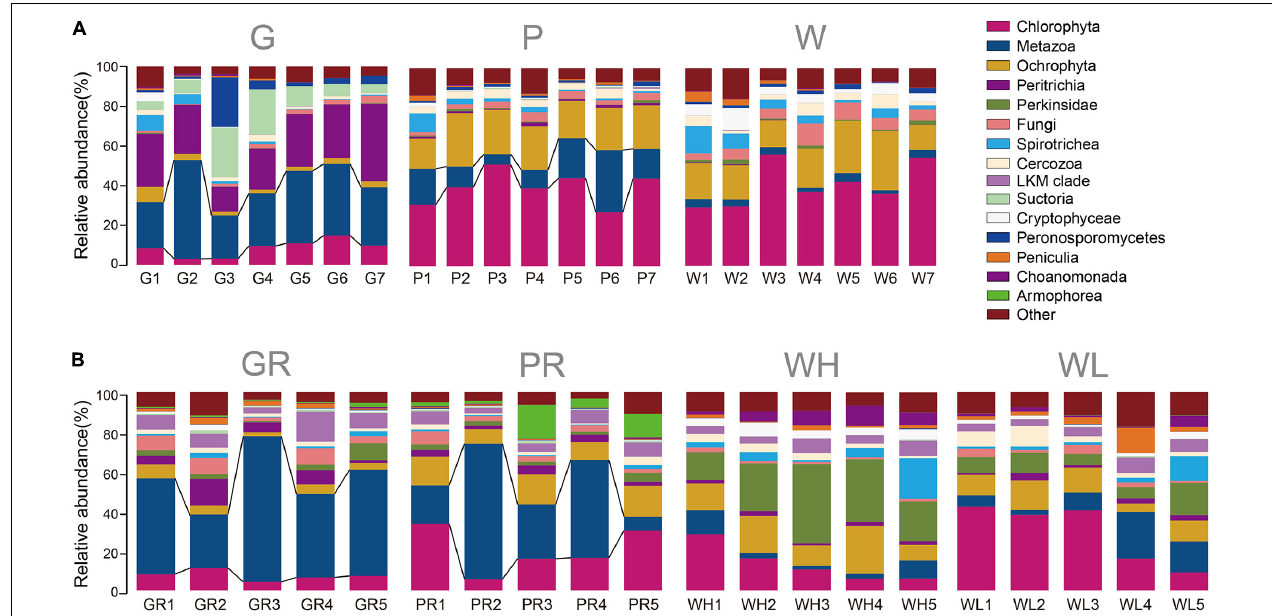
FIGURE 5 | Taxonomic profile of microeukaryotic OTUs of every sample type from the lake (A) and river (B) over time. Samples are named as follows: G, glass slides in Ming Lake; P, PFUs in Ming Lake; W, water columns in Ming Lake; GR, glass slides in Pearl River; PR, PFUs in Pearl River; WH, water columns at high tide in Pearl River; WL, water columns at low tide in Pearl River. The relative abundance of each group > 1% is shown.